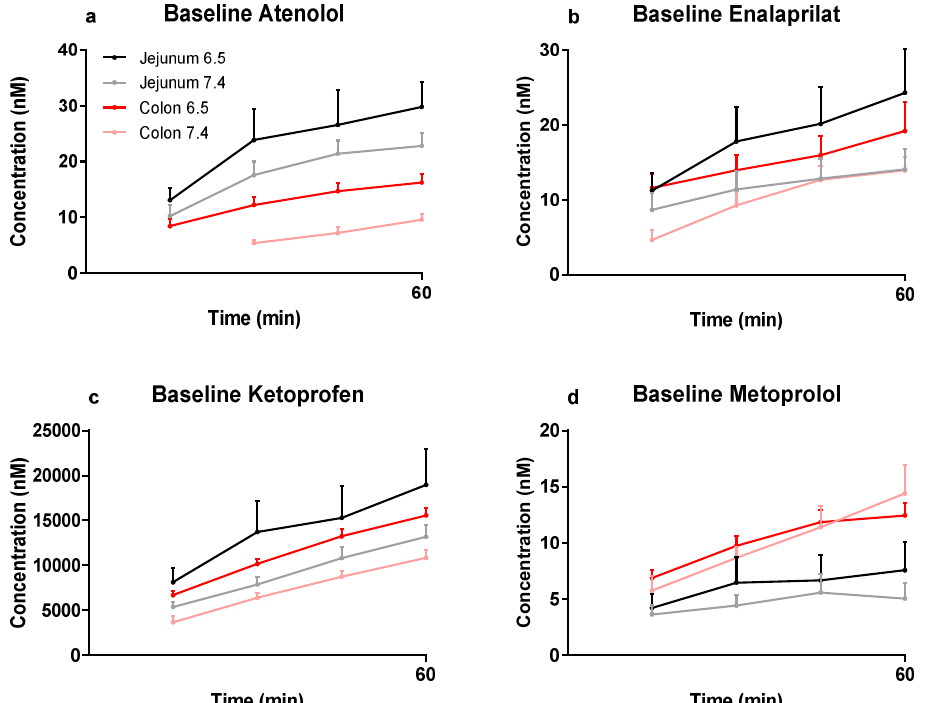
Figure 1. The mean ± SEM rat plasma concentration–time profiles ( n = 30 for colon at pH 7.4, and n = 6 for the other three groups) of: ( a ) atenolol, ( b ) enalaprilat, ( c ) ketoprofen, and ( d ) metoprolol following single-pass jejunal and colonic perfusions of the pH 6.5 and 7.4 control solutions (0–60 min). These plasma data were used to determine regional intestinal basal P eff values using Equation 2 (Table 2).